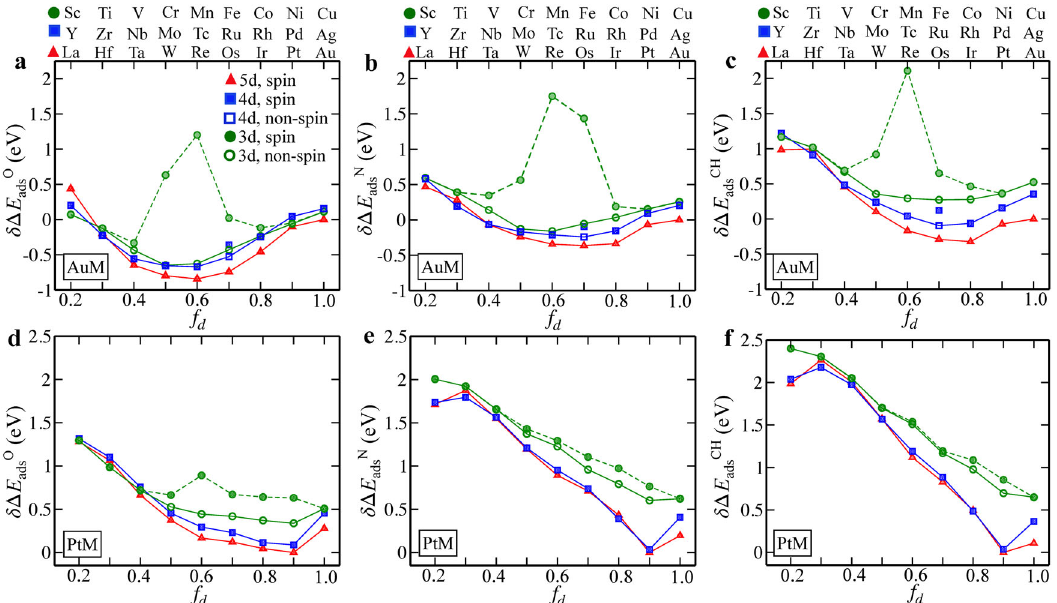
Fig. 7 Variation in chemisorption over Au and Pt-based NSAs. a – c Variation of the DFT calculated adsorption energies of O, N, and CH ( Δ E A ) on Au NSAs as a function of the fractional number of d -electrons ( f d ) in the second layer metal, respectively. Adsorption energies are ads shown relative to the values on pure Au. The fi lled symbols indicate spin-polarized (spin) calculations, whereas the un fi lled symbols are for spin-paired (non-spin) calculations. d – f Show the variation of the adsorption energies of O, N, CH on Pt NSAs relative to pure Pt,